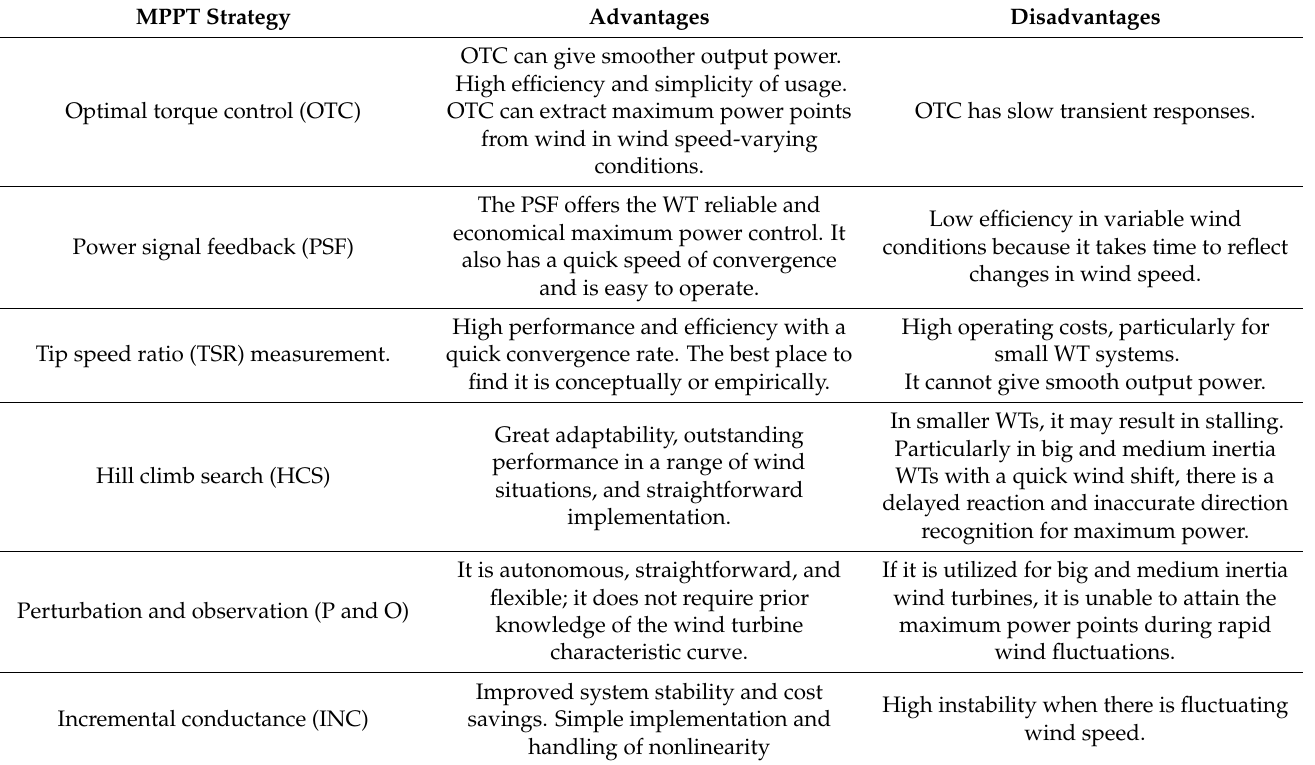
Table 4. Summary of MPPT control techniques [7,34,46,50,54,57].